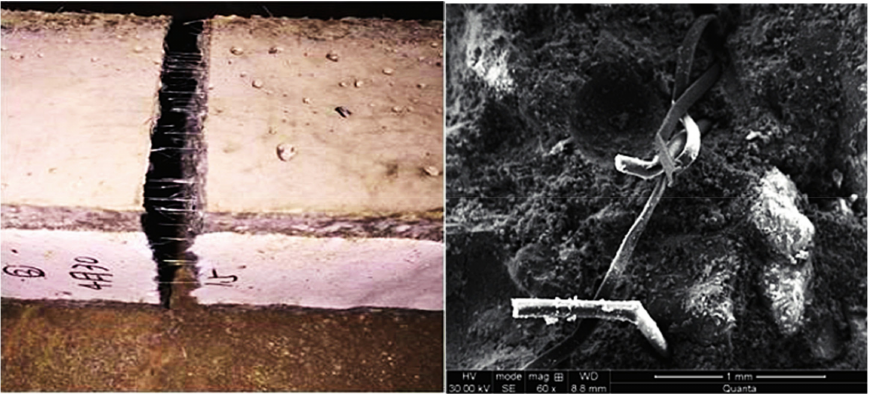
Figure 23. Flexural fracture of coal gangue concrete